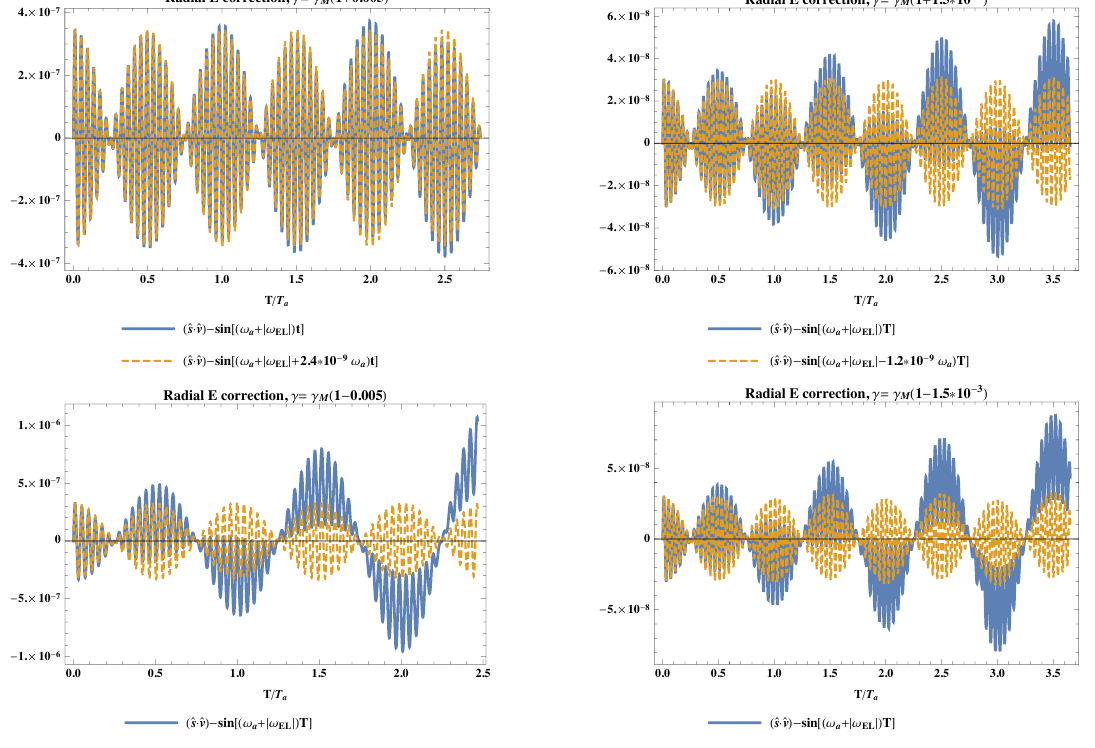
Figure 6 . We have solved numerically the equations of motion on equilibrium orbits with (cid:13) 6 = (cid:13) M and so with x e 6 = 0. We have then evaluated ^ s (cid:1) ^ v = ((cid:6) (cid:1) v ) = ( (cid:13) j v jj S j ) on the solution and compared with a sinusoidal behavior. The plot shows that a better (cid:12)t is achieved by adding the subleading correction (cid:14)! EL ; 2 to the radial electric (cid:12)eld correction of eq. (6.33). The correction turns out to vary with (cid:13) 0 between 10 (cid:0) 9 ! a and few (cid:2) 10 (cid:0) 8 ! a and in a non-symmetric way for values of (cid:13) 0 around the magic momentum (cid:13) M